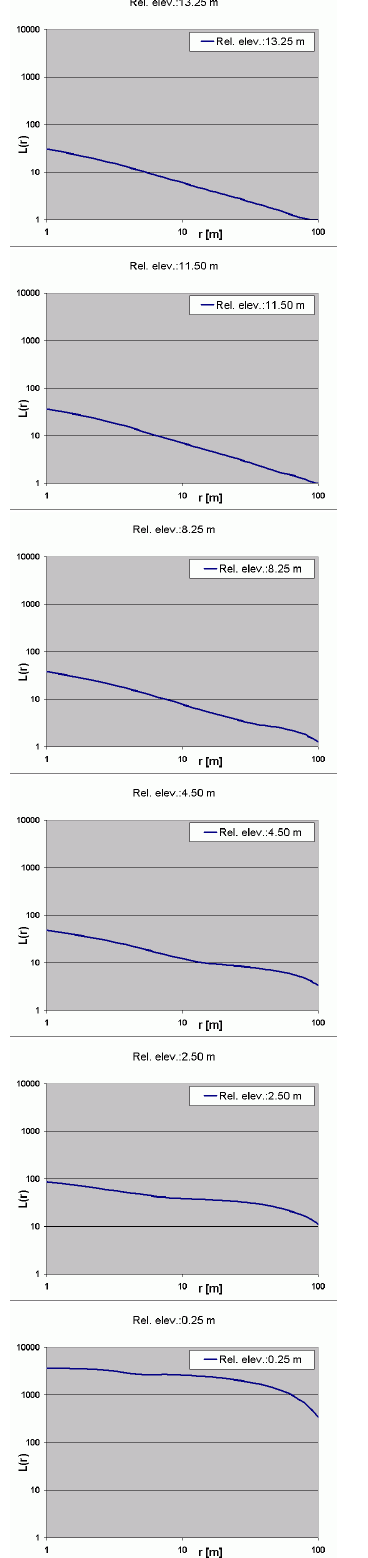
Figure 3. Classic L ( r ) lacunarity curves of the various horizontal layers. See explanation in the text.